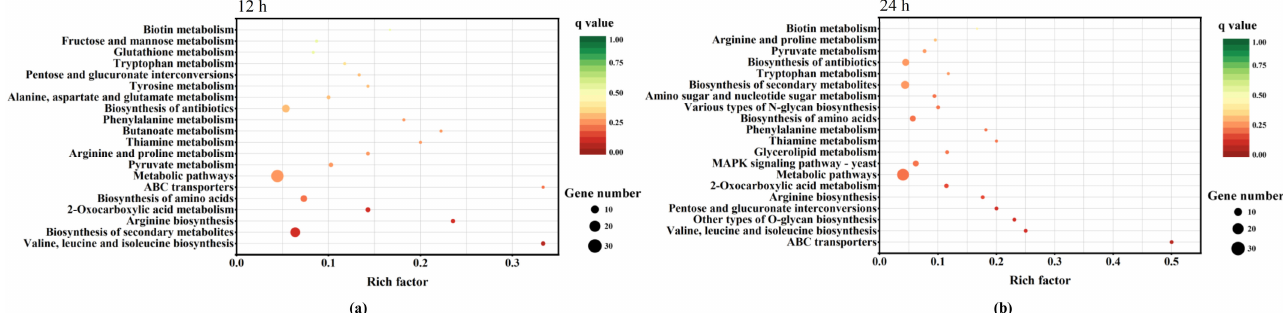
Figure 4. KEGG pathway enrichment scatterplot of differentially expressed genes of P. kudriavzevii C-16 and the type strain ATCC 24210 under lactic acid stress. ( a ) Cultured for 12 h; ( b ) Cultured for 24